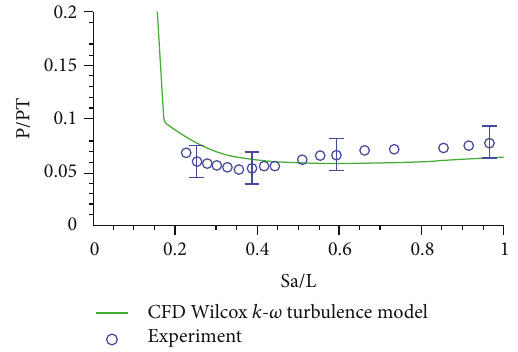
Figure 12: Pressure distribution on model R3.